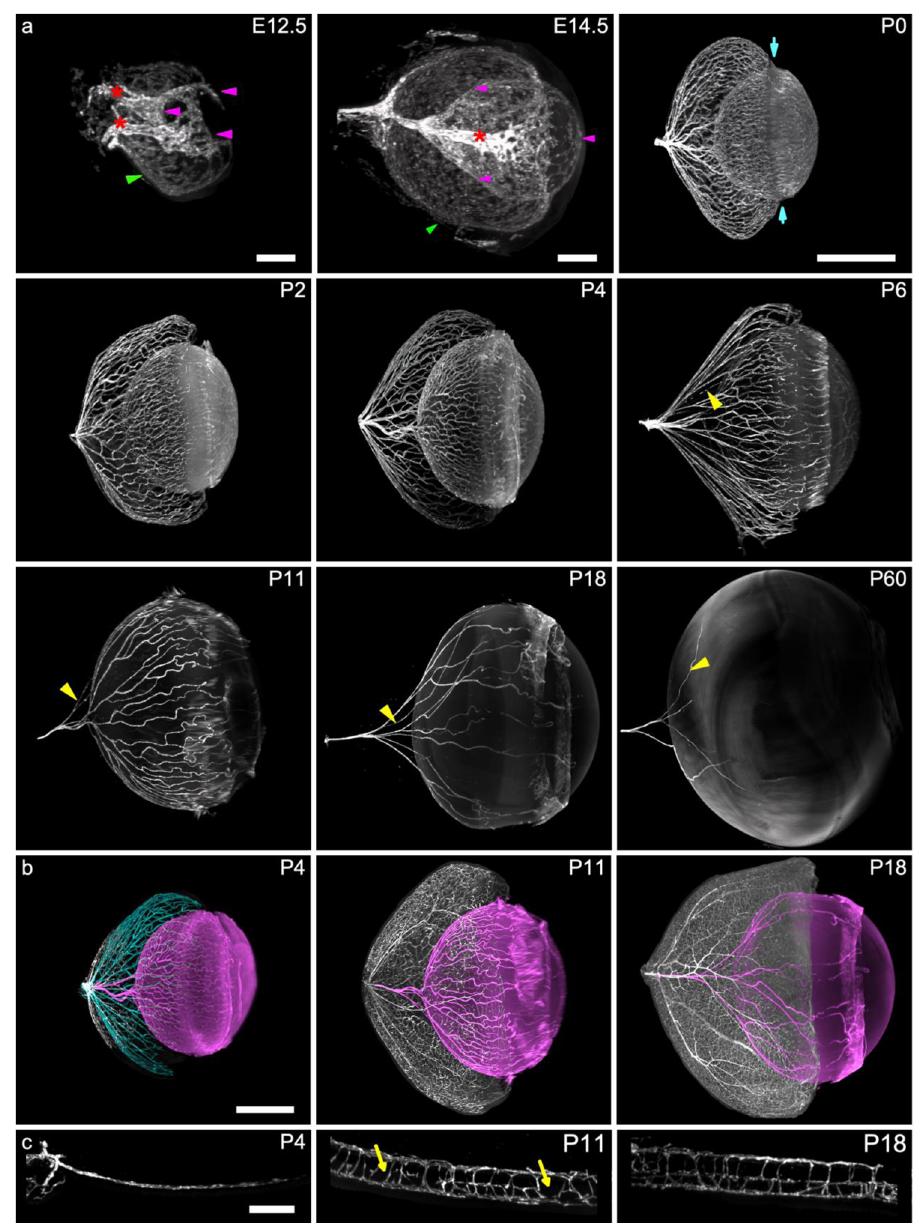
Fig. 2 LSFM imaging of the ocular vasculature during development in the BalbC mouse (anti-CD31 immunolabeling). a successive time-points of hyaloid vessels. Embryo eyes are shown with the choroid (green arrow heads: choroid, magenta arrow heads: HVS); At E12.5 (embryonic day 12.5) there are two long ciliary retinal arteries (red asterisk). At E14.5 the choroid (green arrow heads) is densely vascularized and the entire hyaloid system (magenta arrowheads) is clearly organized. In the subsequent time points, the choroid and retina have been numerically removed. The highest microvascular density was observed at the convergence of the VHP, TVL and PM (blue arrows in P0 for instance). b Superimposed hyaloid and retinal vasculatures of postnatal eyes (VHP in cyan; hyaloid arteries: TVL and PM in magenta). c developing retinal vasculature showing the monolayered (P0), partially (P11; asterisks indicate discontinuities of intermediate plexus) and fully trilayered (P18) structures (yellow arrowhead: regressing vessels) (Scale bars: panel a and b 500 µ m except for E12.5 and E14.5 (200 µ m); panel c : 100 µ m; VHP vasa hyaloidea propria, TVL tunica vasculosa lentis, PM pupillary